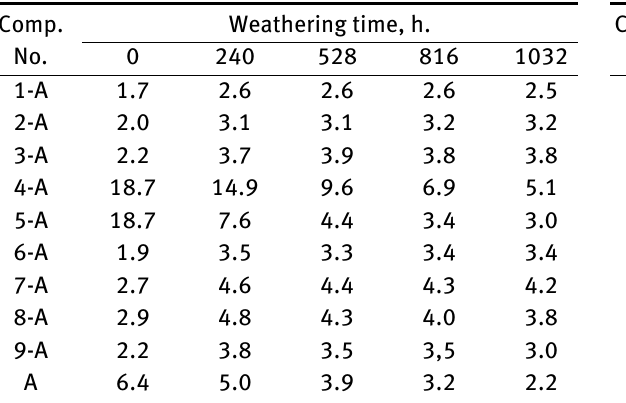
Table 3: Changes of the surface gloss of all composites as a func- tion of the weathering time 1 Comp.